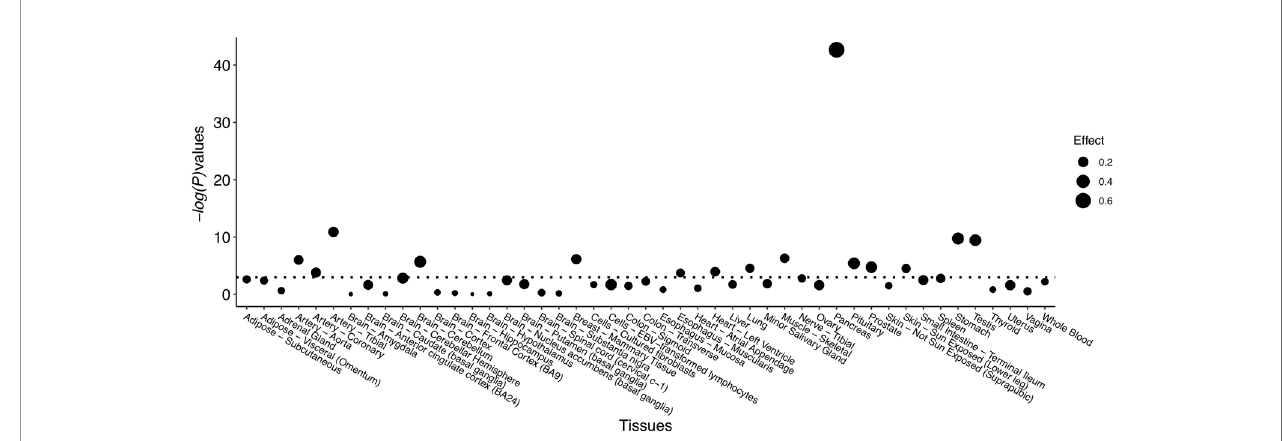
FIGURE 1 | eQTL signals identi fi ed for SNP rs80196932 on gene NUS1 from multiple types of human tissues. Threshold of -log( P -value) is indicated by